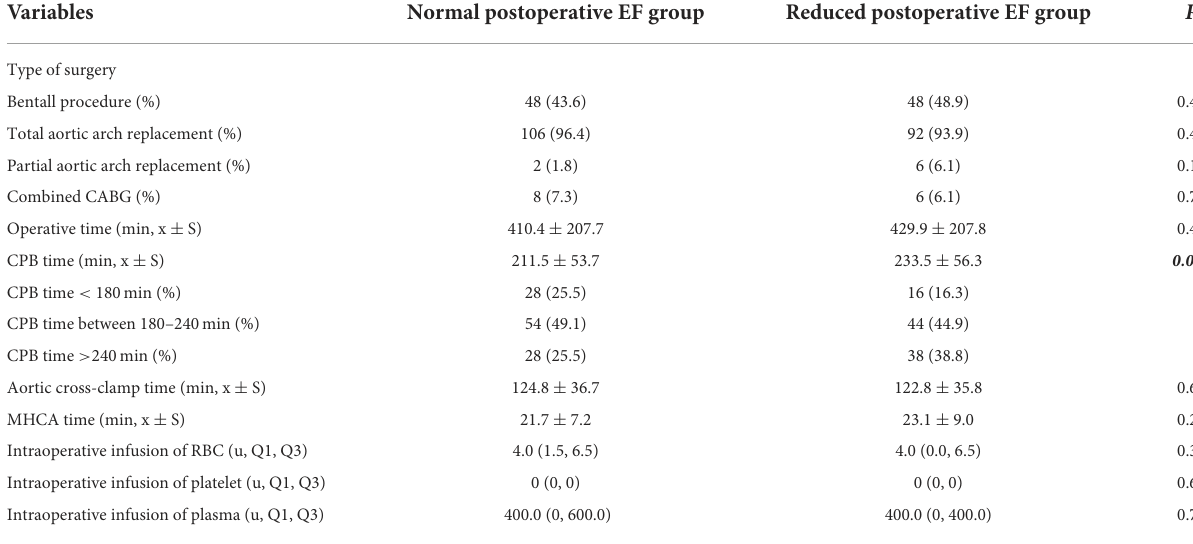
TABLE 2 Comparison of the intraoperative variables between the normal postoperative EF group and the reduced postoperative EF group.